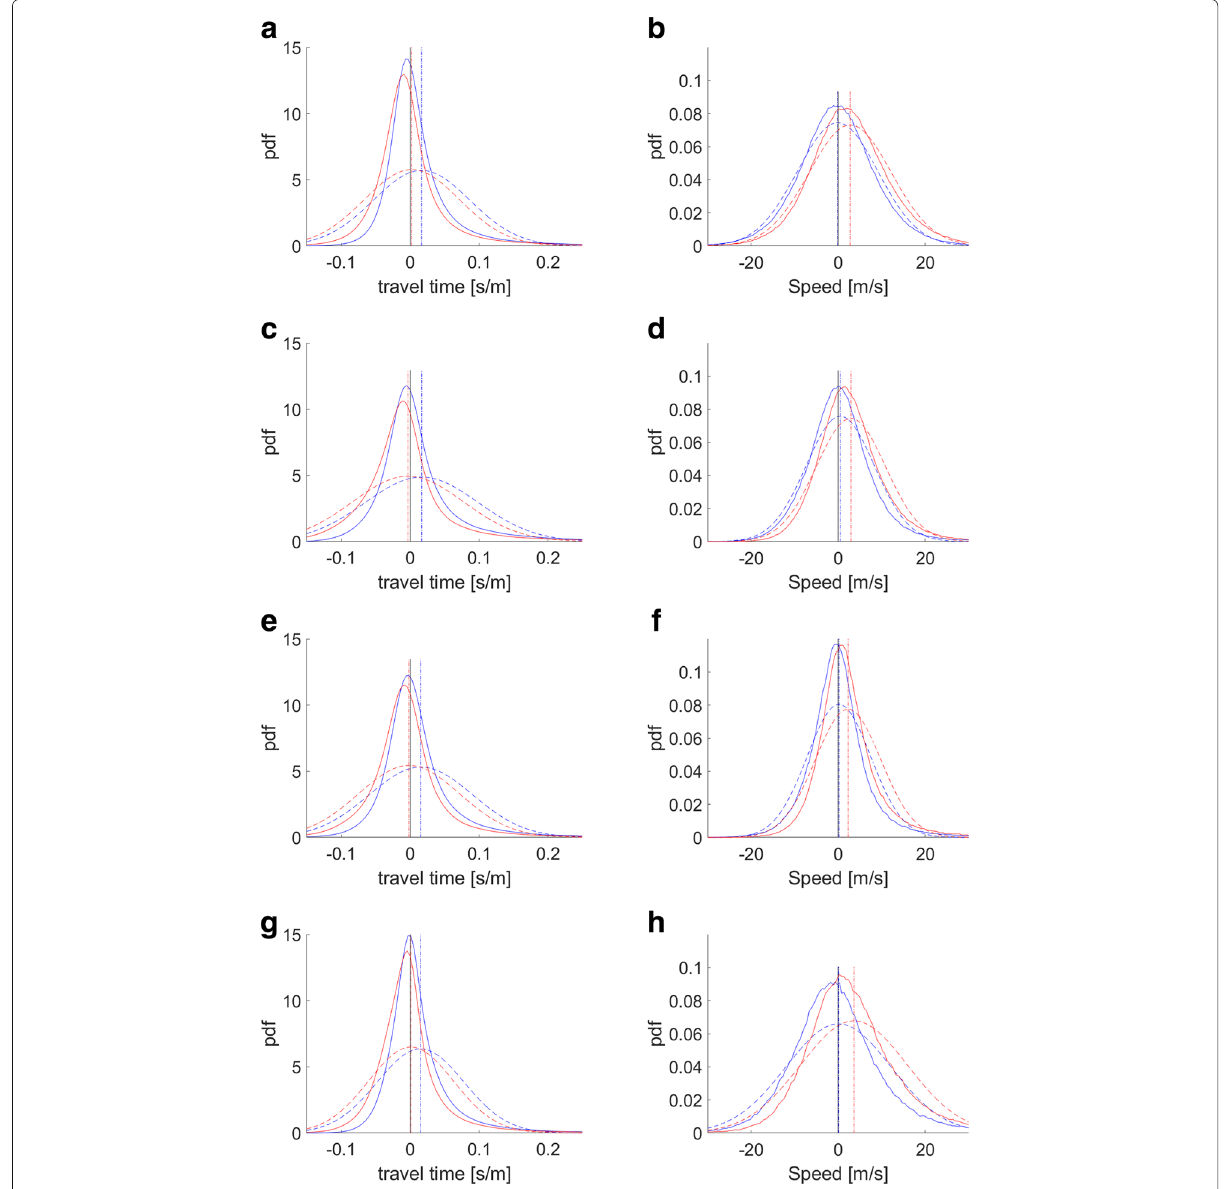
Fig. 4 Kernel density estimate for residuals of link travel times ( a , c , e , g ) and link speeds ( b , d , f , h ) for all links, all time-of-day-intervals on the validation set for Hietzing ( a , b ), Westbahnhof ( c , d ), Ring ( e , f ) and Südosttangente ( g , h ). Indirect method in blue, direct method in red. Estimated means are indicated as dash dotted lines, normal densities as broken